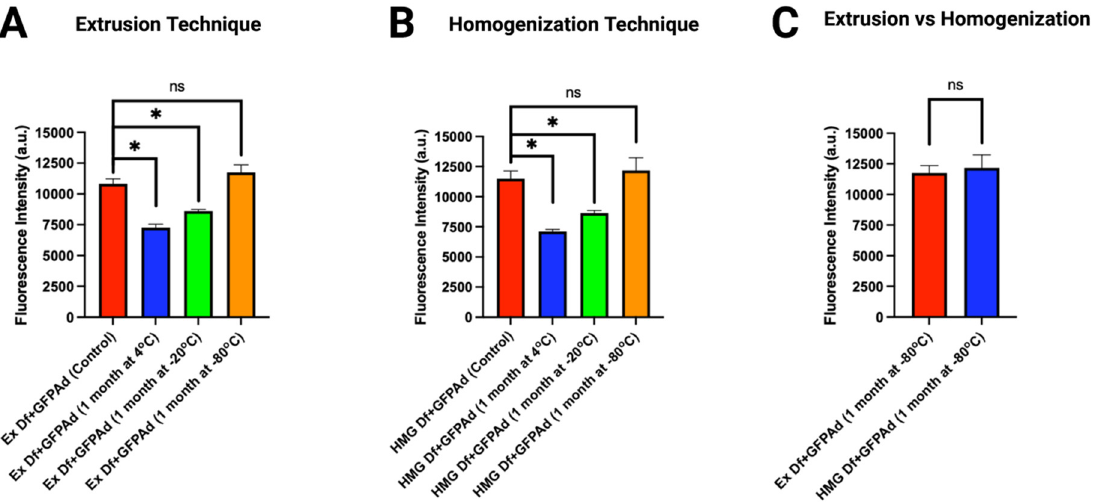
Figure 6. Comparative in vitro transduction of Ad liposomes manufactured by extrusion and homogenization on CAR positive and CAR deficient cell lines at MOI 50 (n = 3): ( A ) In vitro transduction of unencapsulated GFPAd (yellow bar) Ex Df + GFPAd (red bar) and HMG Df + GFPAd (blue bar) on CAR positive HEK293 cells ( p value: ns = not significant, * ≤ 0.05, ** ≤ 0.01). ( B ) In vitro transduction of unencapsulated GFPAd (yellow bar) Ex Df + GFPAd (red bar) and HMG Df + GFPAd (blue bar) on CAR positive A549 cells ( p value: ns = not significant, ** ≤ 0.01). ( C ) In vitro transduction of unencapsulated GFPAd (yellow bar) Ex Df + GFPAd (red bar) and HMG Df + GFPAd (blue bar) on CAR deficient 4T1 cells ( p value: ns = not significant, ** ≤ 0.01, *** ≤ 0.001). ( D ) in vitro transduction of unencapsulated GFPAd (yellow bar) Ex Df + GFPAd (red bar) and HMG Df + GFPAd (blue bar) on CAR deficient MCF7 cells ( p value: ns = not significant, *** ≤ 0.001, **** ≤ 0.0001).